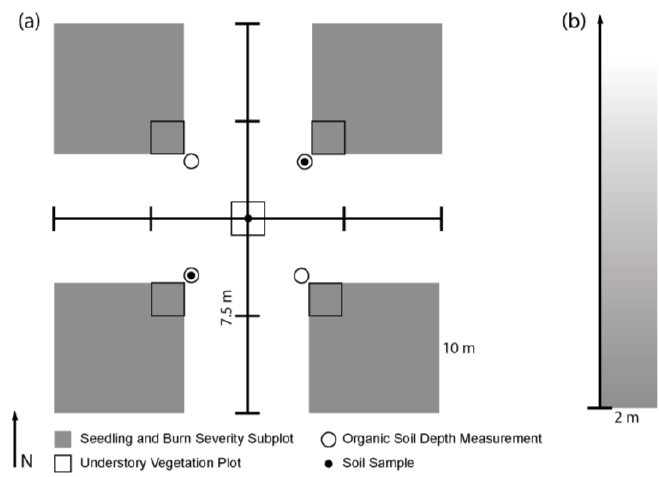
Figure A1. Plot layouts used for field sampling: ( a ) 30 × 30 m square plot one year post-fire; and ( b ) 35 × 2 m belt transect for re-measurement of seedlings three years post-fire. Plot layouts and symbols are not to scale.